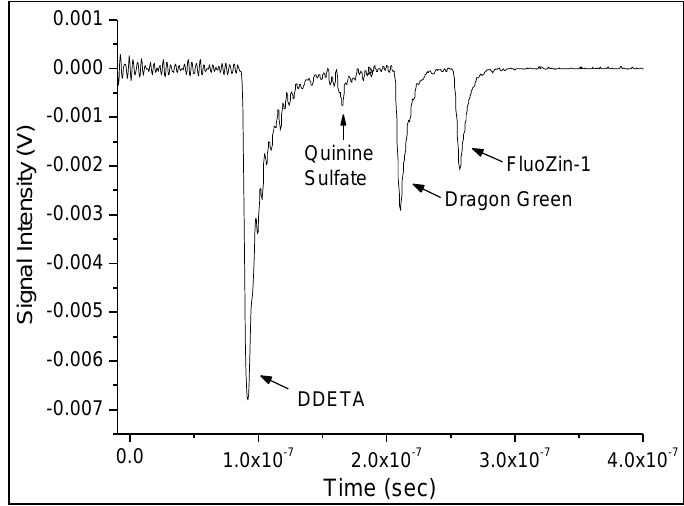
Figure 8. The output trace collected from an oscilloscope depicting the detection of every sensor in the four-sensor array in time. The zero point in time indicates excitation pulse generation.